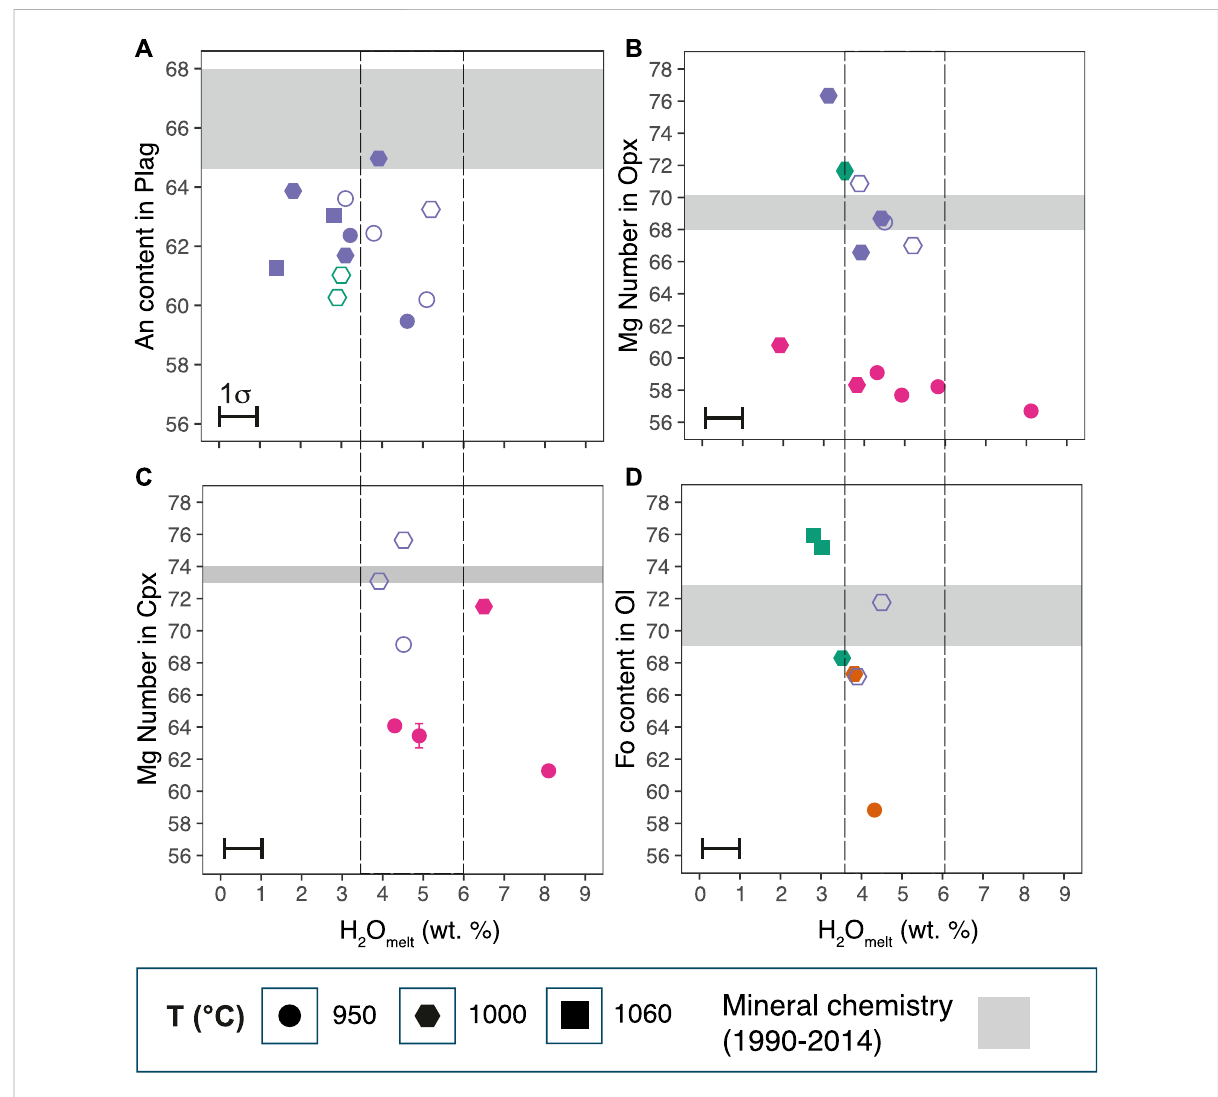
FIGURE 6 Experimental mineral compositions compared to natural minerals from the 1990, 2007, and 2014 eruptions (A) An content in Plag, (B) Mg Number in Opx, (C) Mg Number in Cpx, and (D) Fo content in Ol. Gray horizontal bands are of the mineral compositions from the three eruptions taken from the core compositions of the minerals (Data from Table 3 and Supplementary Table S2 of this study). Only the rim compositions of the Plag are to compare with experiments. Filled symbols represent the experiments at NNO; open-lined symbols represent experiments at NNO